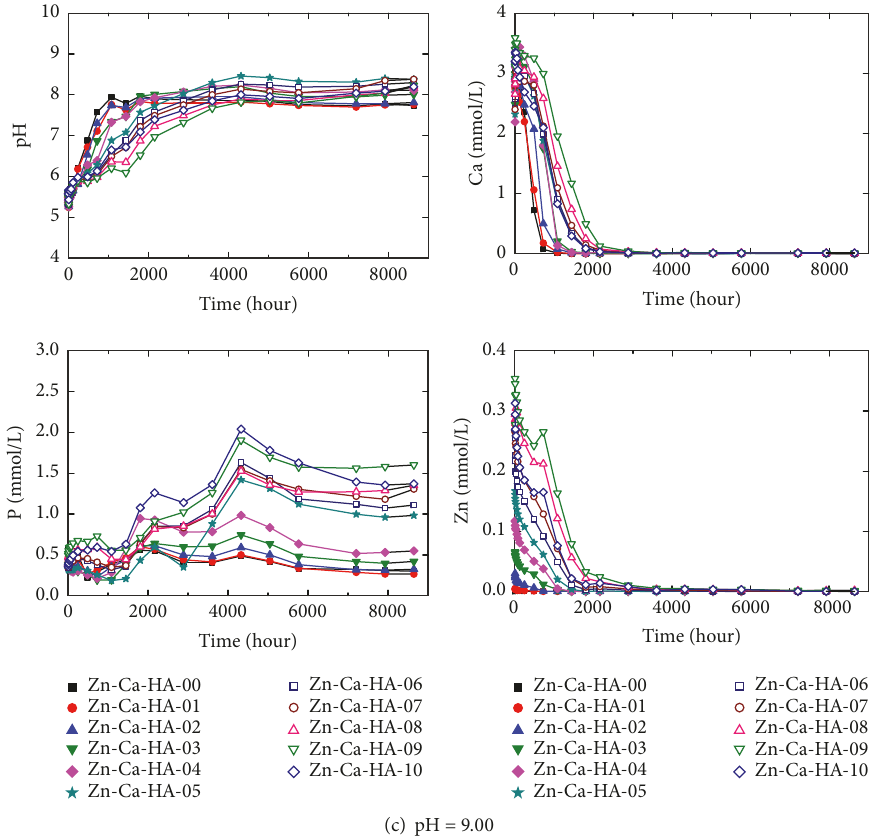
Figure 4: (a) Change of the solution pH and elemental concentrations with time for the dissolution of the Zn-substituted hydroxylapatites [(Zn Ca 1− ) 5 (PO 4 ) 3 OH] at 25 ∘ C with an initial pH of 2.00 for 360 d. (b) Change of the solution pH and elemental concentrations with time for the dissolution of the Zn-substituted hydroxylapatites [(Zn at 25 ∘ C with an initial pH of 9.00 for 360